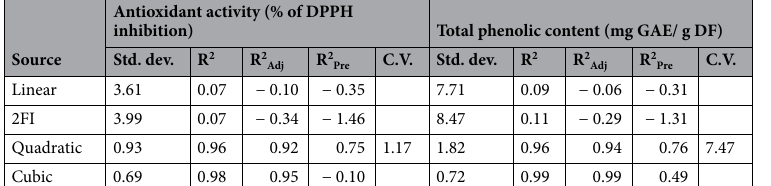
Table 2. Experimental design using RSM with CCD for the antioxidant activity (% of DPPH) and total phenolic content (TPC).